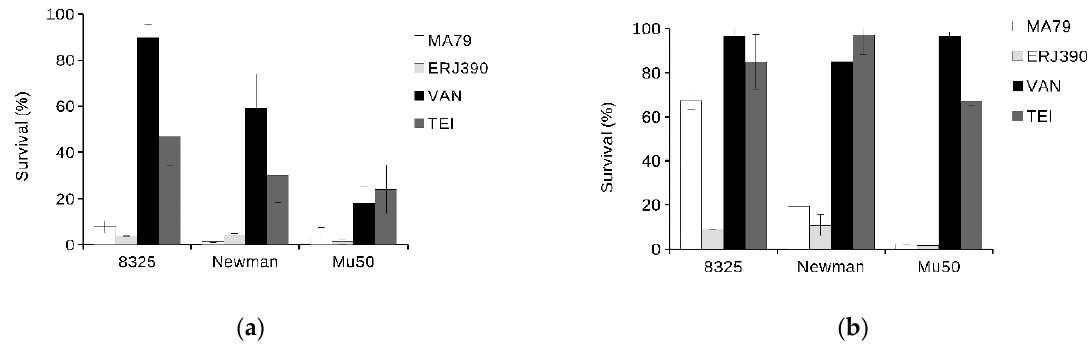
Figure 4. Killing of cells of different S. aureus strains during one hour of treatment by antibiotics vancomycin (VAN), teicoplanin (TEI), MA79, and ERJ390 pre-grown to exponential ( a ) or stationary ( b ) growth phases. The antibiotics were used at a concentration exceeding the MIC 5-fold and 50-fold against S. aureus cells in exponential or stationary growth phases, respectively.